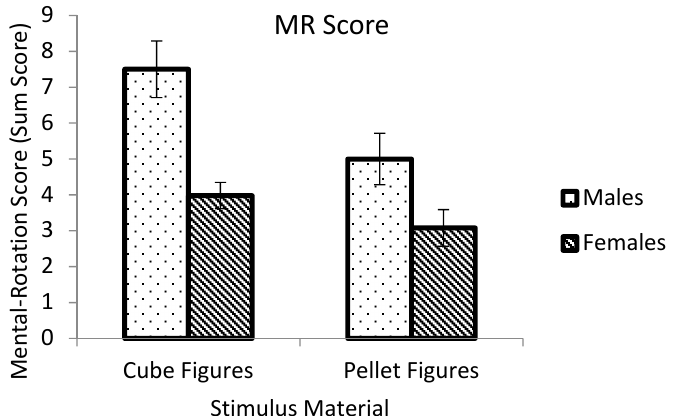
Figure 2. Mental-rotation score as a function of rotational objects and participants’ gender. Error bars indicate SE.